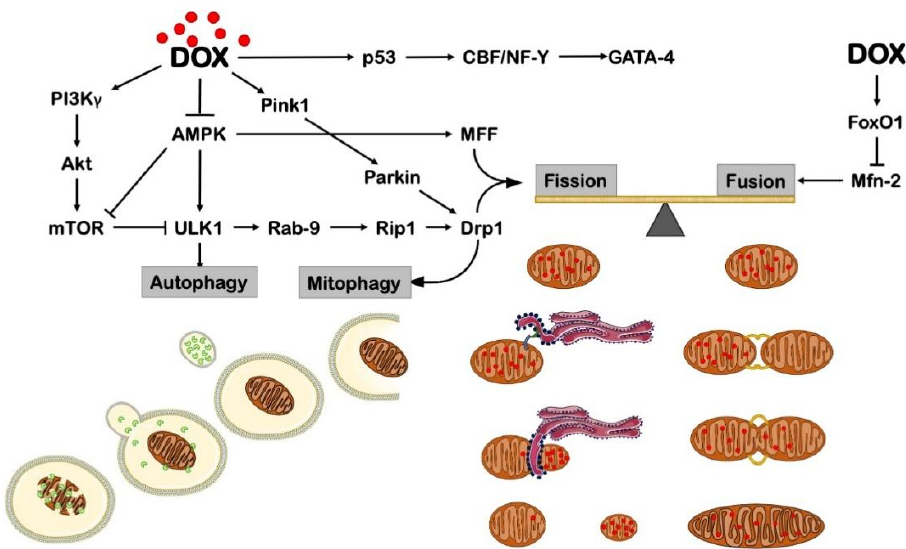
Figure 3. DOX impairs mitochondrial dynamics and mitophagy through different pathways. AMPK = AMP-activated protein kinase; CBF/NF-Y = CCAAT-binding factor/nuclear factor-Y; DRP1 = dynamin-related protein 1; FoxO1 = Forkhead box protein O1; GATA4 = GATA-binding protein 4; Mfn-2 = mitofusin 2; mTOR = mechanistic target of rapamycin complex 1; PI3K γ = phosphoinositide 3-kinase γ ; PINK1 = PTEN-induced kinase 1; RAB-9 = Ras-related protein Rab-9; RIP1 = receptor-interacting protein 1; ULK1 = unc-51-like kinase 1. This illustration includes elements from Servier Medical Art.